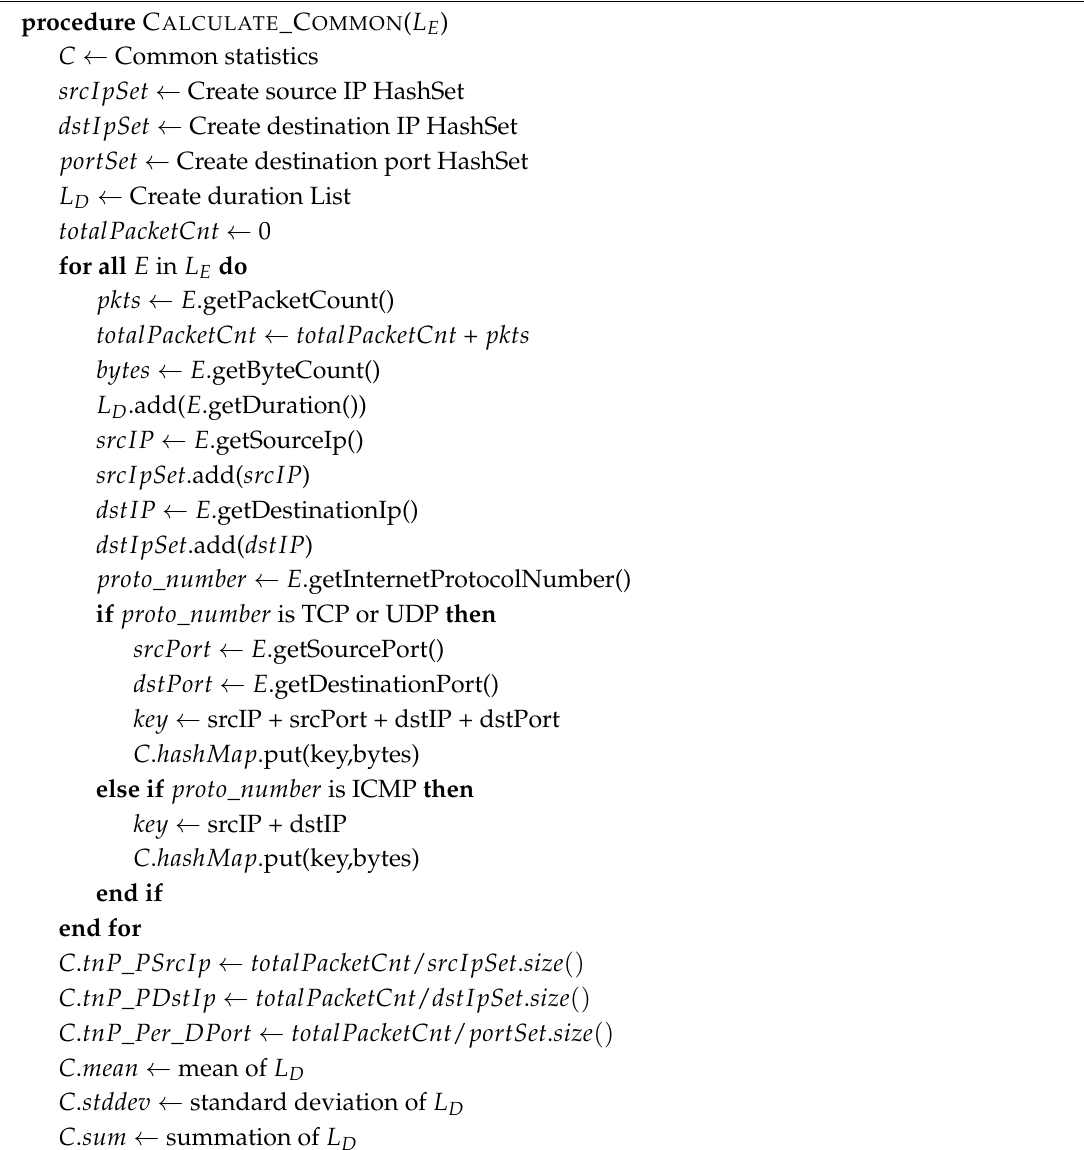
Algorithm 3 Calculation of common statistics and